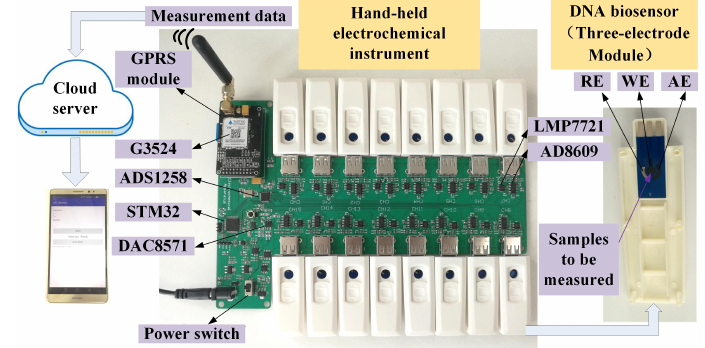
Figure 1. Image of the measurement system.